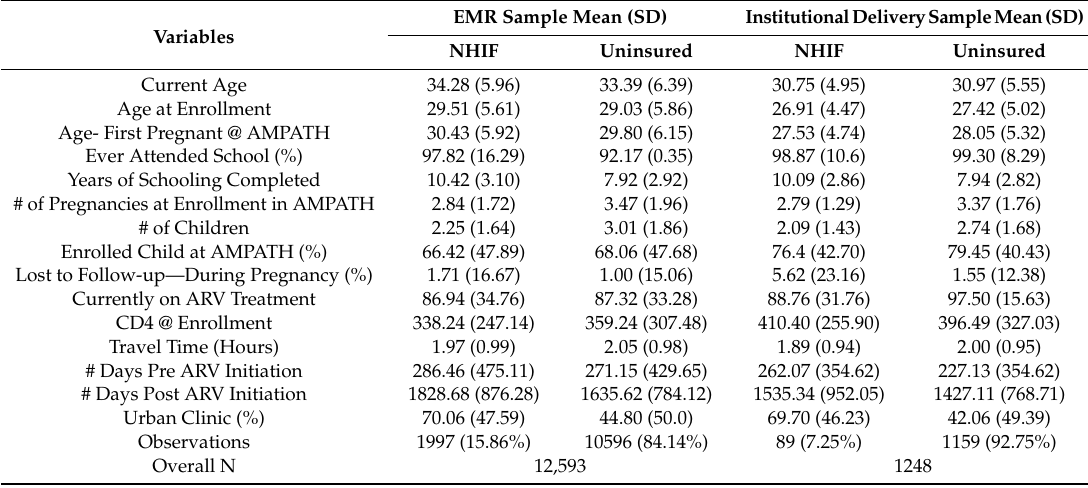
Table 1. Socio-Demographic Characteristics of HIV positive Pregnant Women within AMPATH EMR.